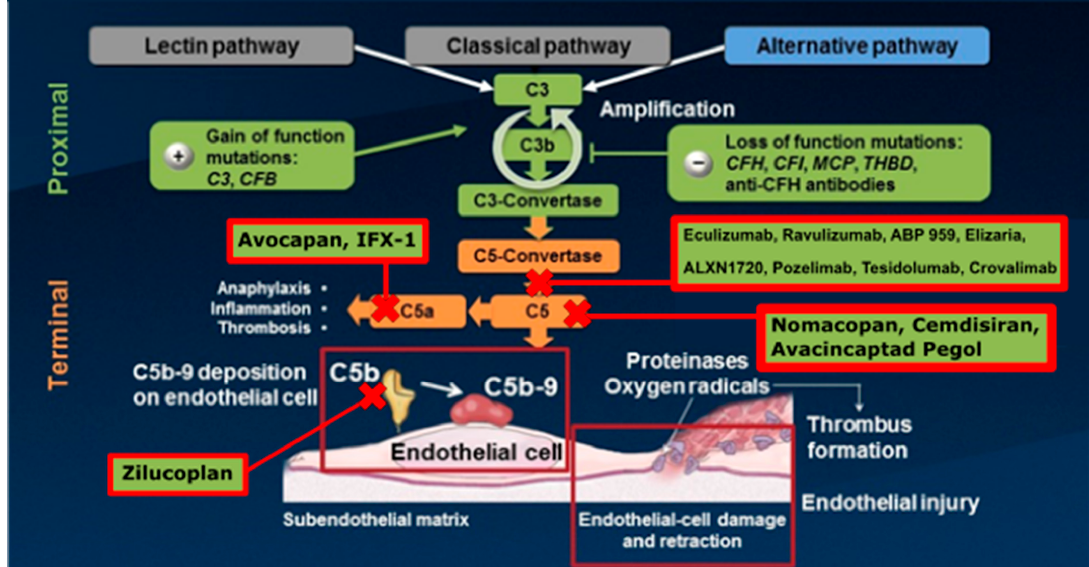
Figure 1. Alternative pathway with key emphasis on interventional drugs and where they act upon. Current therapeutics include Eculizumab, Ravulizumab, Avocapan, Nomacopan, and Cemdisiran. Biosimilars include ABP 959 and Elizaria. Drugs currently being developed include ALXN1720, Poselimab, Tesidolumab, Crovalimab, Avacincaptad Pegol, IFX-1, and Zilucoplan.